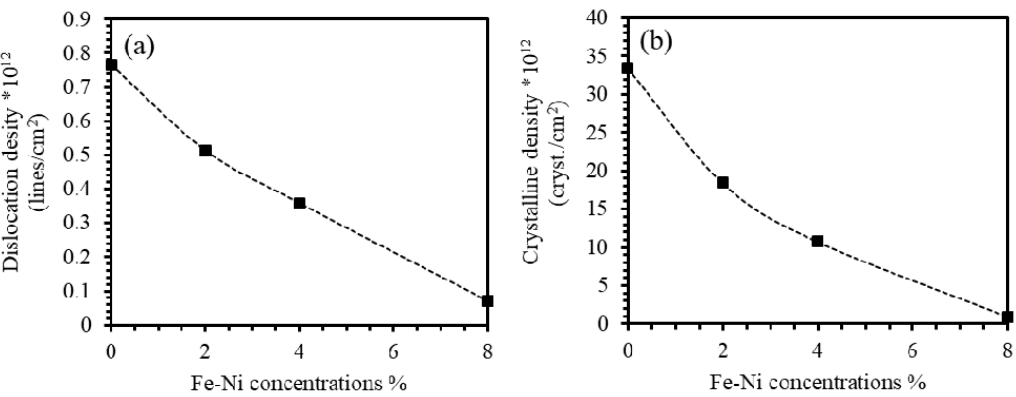
Figure 4. ( a ) Dislocation density and ( b ) crystalline density of undoped ZnO and Fe-Ni co-doped ZnO thin films as a function of Fe-Ni concentration.